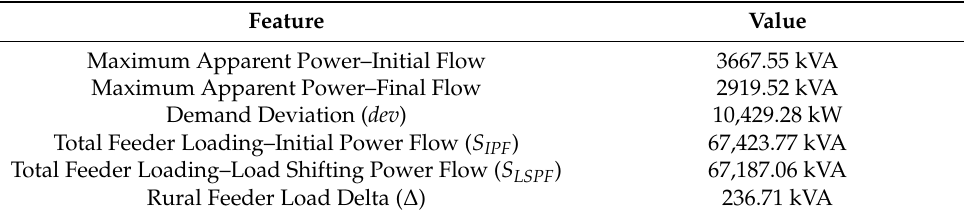
Table 7. Summary on the application of the load shifting strategy on Rural Feeder B. Source: The